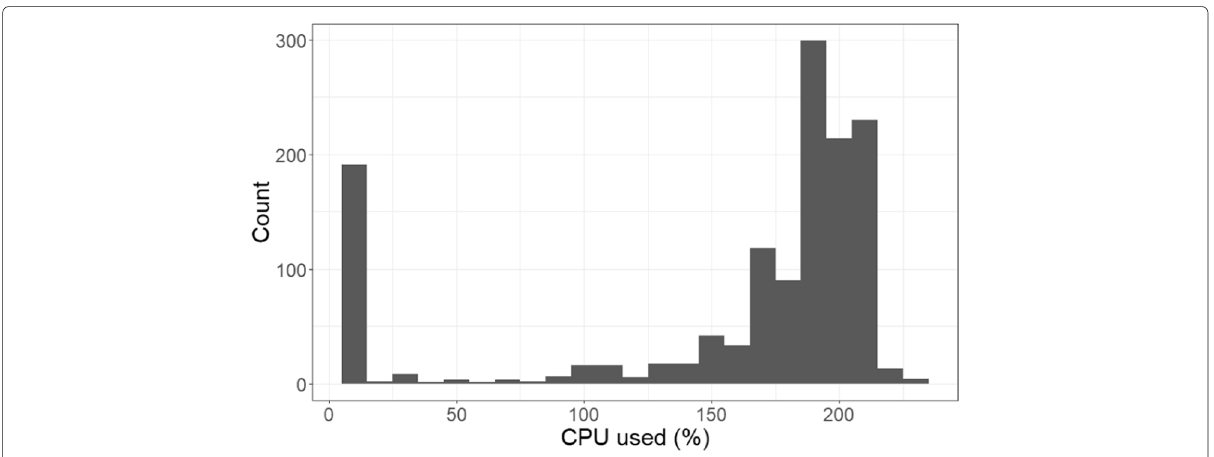
Fig. 6 Measured CPU use per second